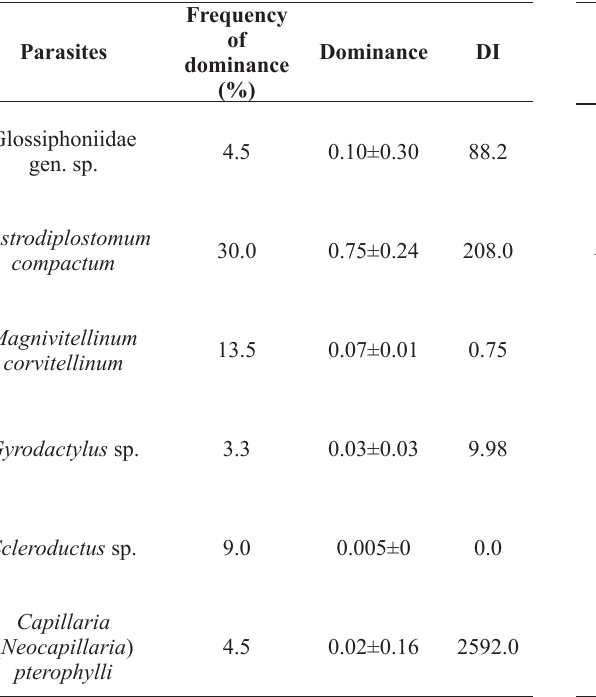
Frequency of dominance, dominance and dispersion index (DI) of the metazoan parasites of Hoplosternum littorale (Hancock 1828), collected in the Mouth of the Peixe River, Middle Tietê, São Paulo,